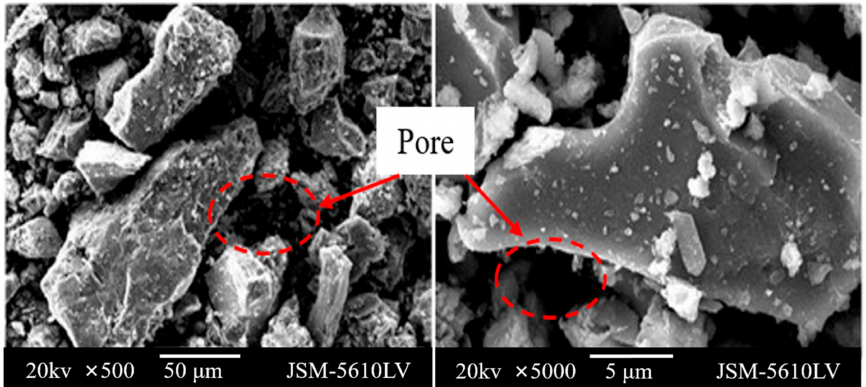
Figure 3. Scanning electron microscopy (SEM) images of BOFS.